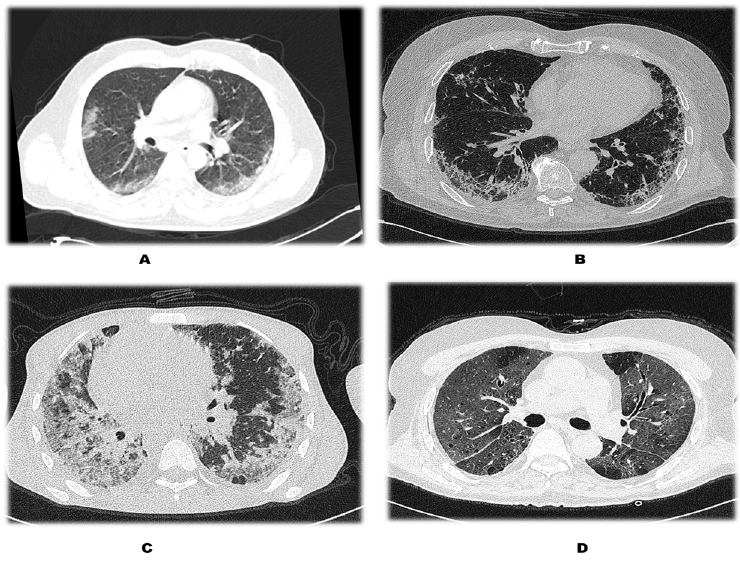
Figure 1. Pictorial representation of the severity of COVID-19 axial HRCT chest cuts with lung window demonstrating severity of disease: ( A ) Left upper—mild disease, ( B ) right upper—moderate disease, ( C , D ) severe disease. Table 5. Association of CT severity score in patients with and without